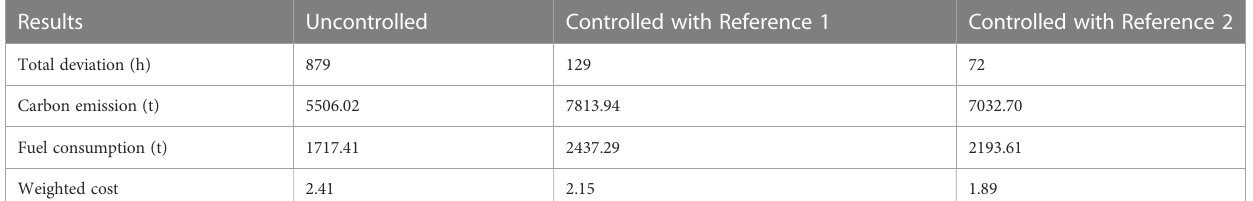
TABLE 5 Results under different control methods.